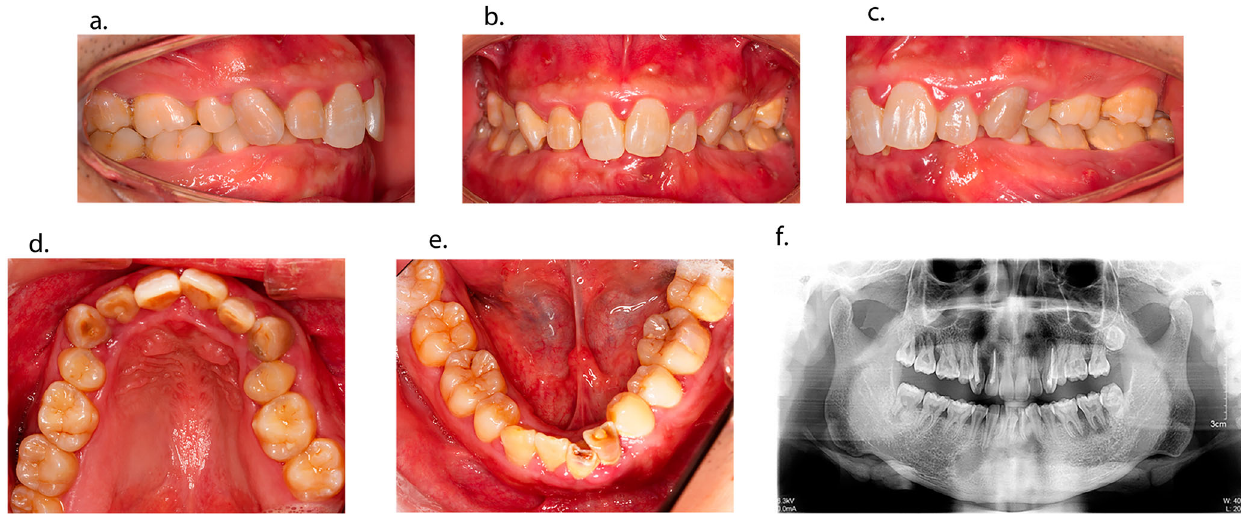
Fig. 1 Intraoral views and panoramic radiograph of a 32-year-old male patient with HR. Intraoral views ( a – e ) showed multiple fi stulas and abscesses, malocclusion, and dental attrition in the left lower incisors; Panoramic radiograph ( f ) revealed enlarged pulp chambers, the radiolucencies at periapical regions of teeth # 12, 13, 17, 22, 23, 32, 36, 37, 41, 42, 43 and 48, and the presence of endodontically treated teeth # 12, 13, 23 and